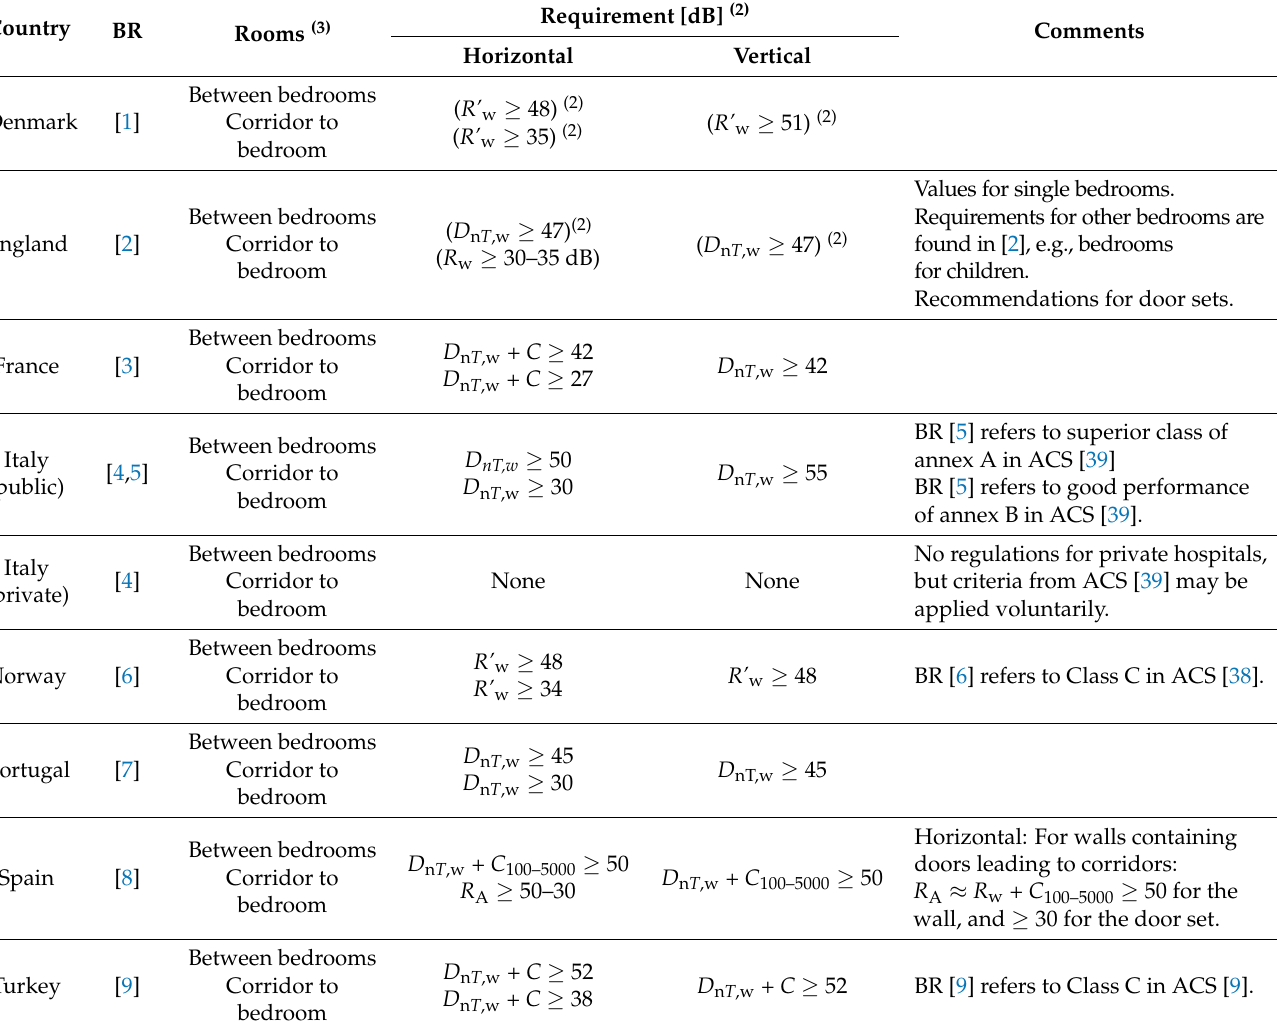
Table 2. Acoustic regulations for hospital bedrooms (1) —Airborne sound insulation. November